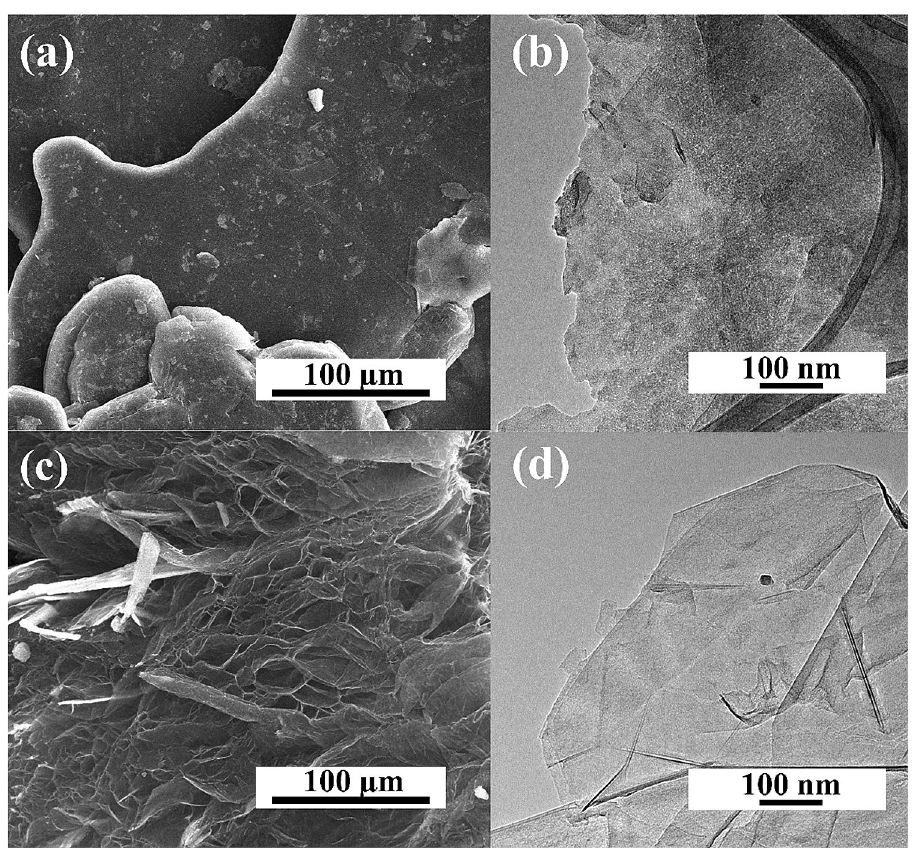
Figure 2. SEM and HRTEM images of graphene foams obtained without and with N-reagent: ( a , b ) 0A-10 and ( c , d )